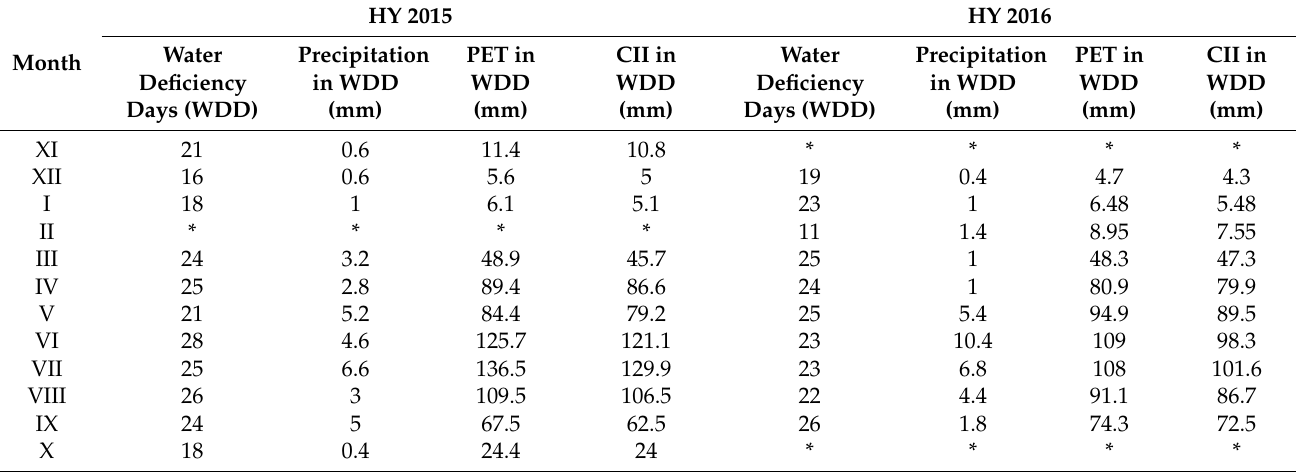
Figure 2. Monthly totals of the CII and its components (P and PET). Table 5. Sum of the occurrences of days with water deficiencies during the hydrological years 2015 and